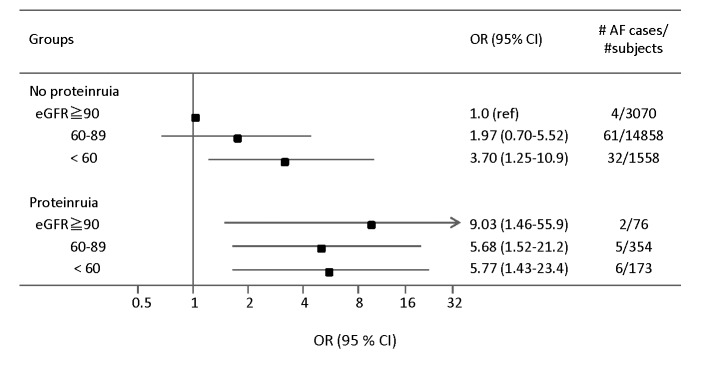
Odds ratios (OR) and 95% confidence intervals (CI) of atrial fibrillation (AF) according to presence of proteinuria and eGFR.Multivariable logistic regression models adjusted for age, gender, hypertension, diabetes mellitus, smoking, and cardiac disease.